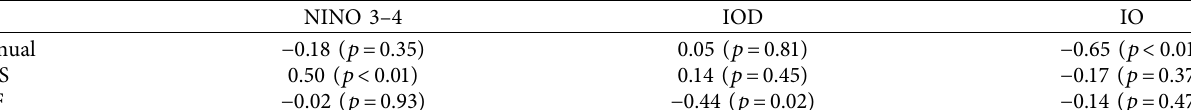
Table 1: Lagged correlation of JJAS rainfall with NINO, IOD, and IO during 1991–2020.